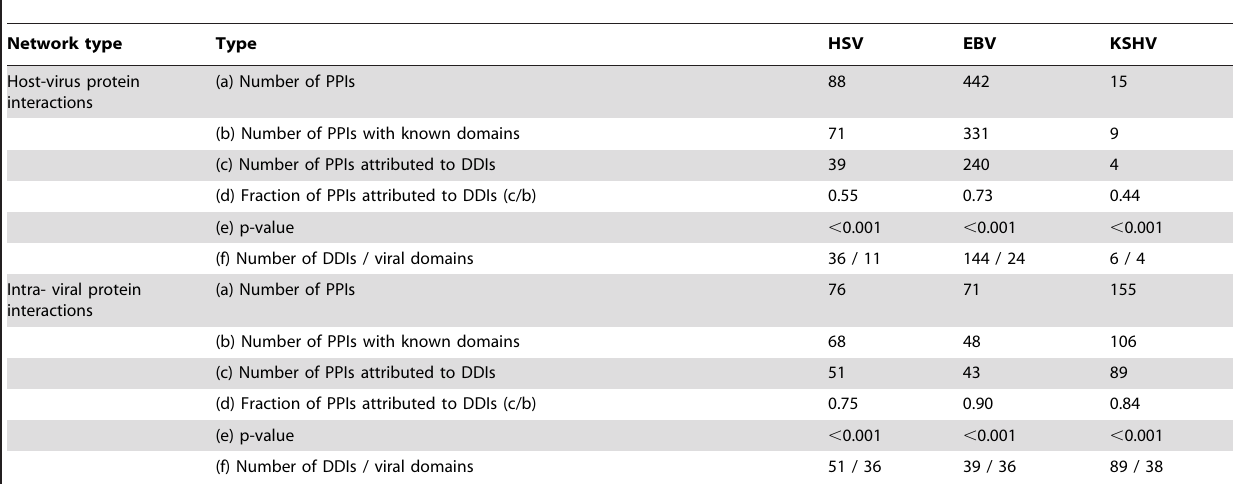
Table 1. DDI-PPI mapping of intra-viral and human-virus protein interactions.